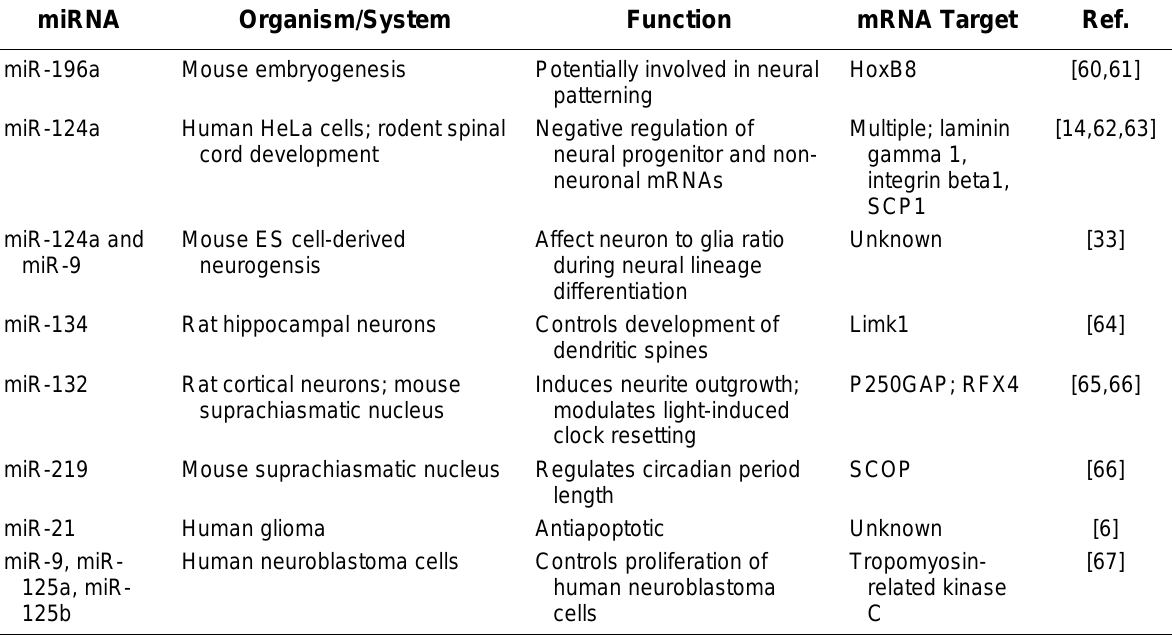
miRNAs with Potential Functions in Developing and Mature Mammalian Nervous System and Human Brain